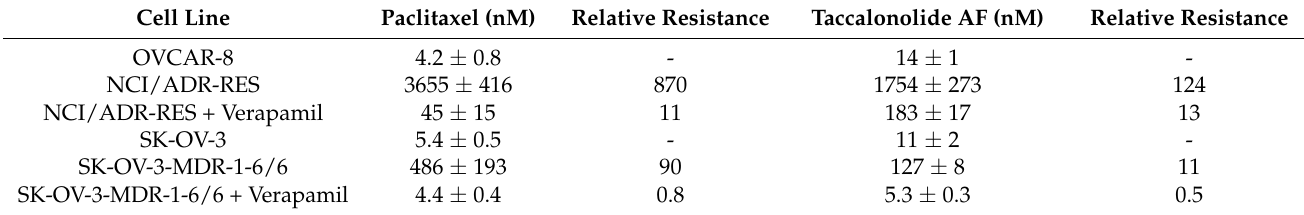
Table 1. GI 50 (nM) of paclitaxel and taccalonolide AF in MDR 1-expressing ovarian cancer cell lines as compared to isogenic parental lines or in the presence of the Pgp-inhibitor verapamil. Mean ± SEM n = 3–5. Relative resistance calculated as the GI 50 of the MDR1- expressing cell line divided by the GI 50 value in the isogenic parental line.